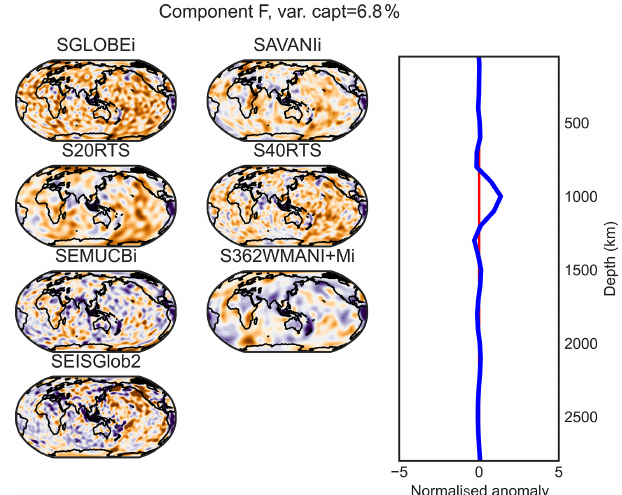
Figure 5. PC F (maximum at 1000km of depth) of the combined analysis of the isotropic models. On the right are the principal com- ponents or vertical profiles, and on the left are the associated hori- zontal structures. The other components are shown in the Appendix in Figs.